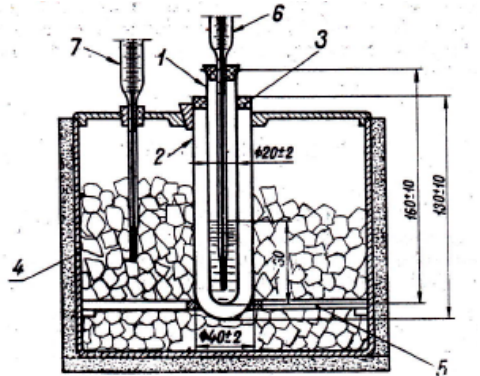
Figure 6. Equipment for freezing point determination.